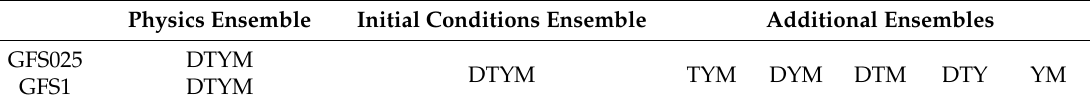
Table 2. Model ensemble combinations 1